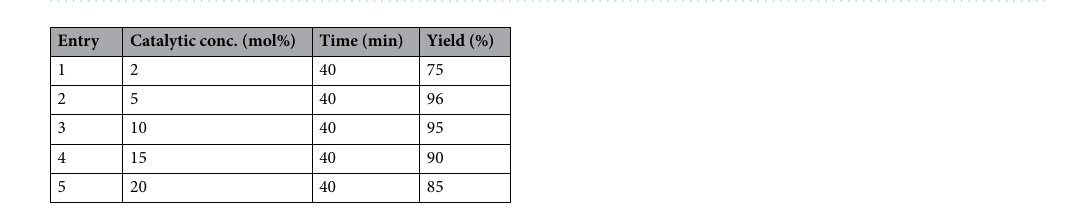
Table 2. Optimization of catalytic amount of green NiO NPs in the aqueous synthesis of 5g .